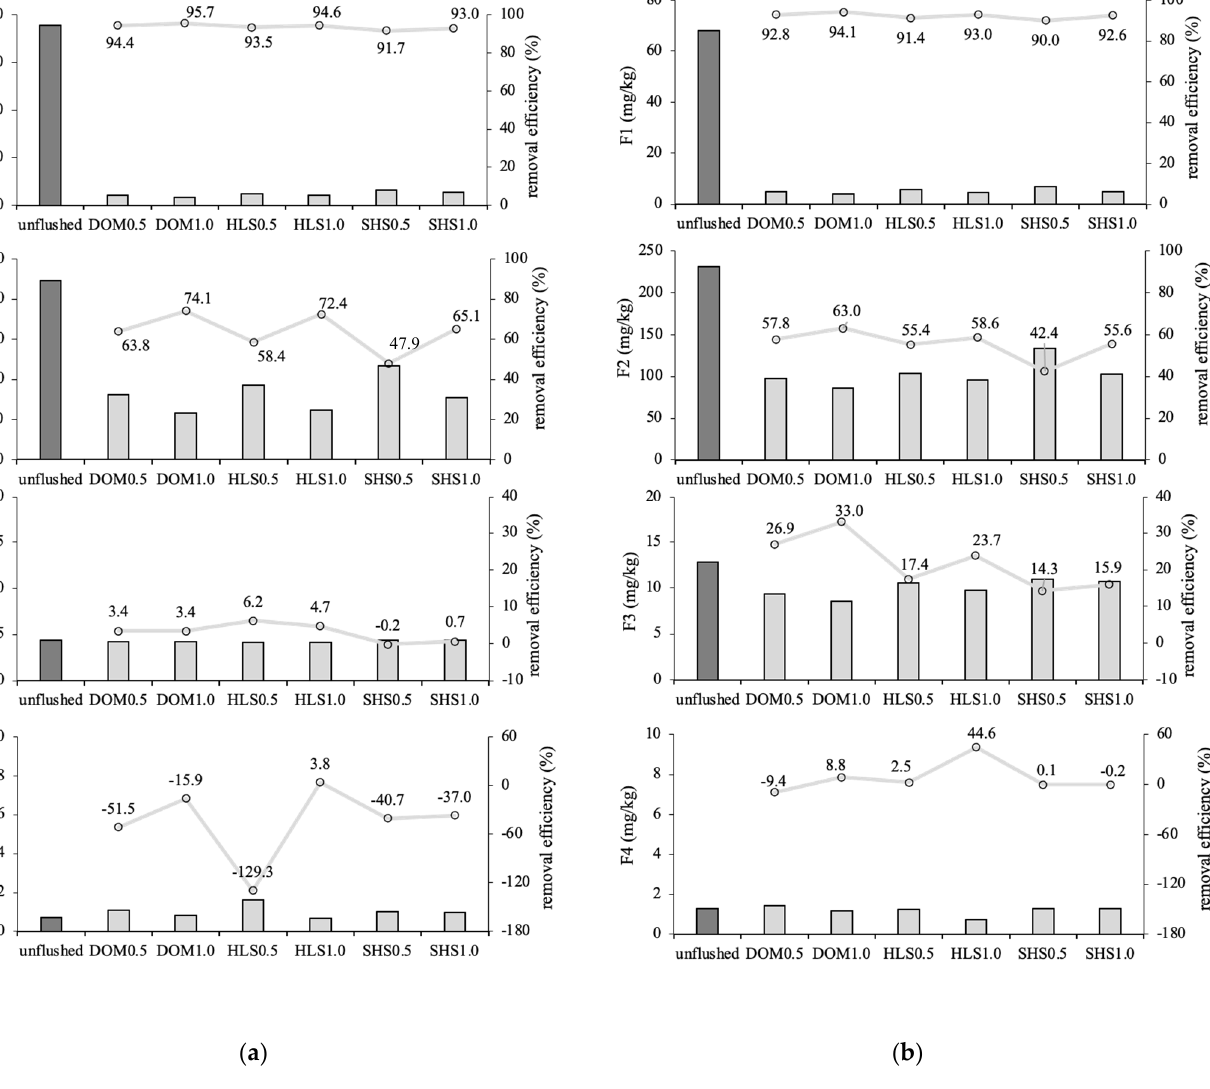
Figure 2. Distribution of chemical forms (F1, exchangeable and acid-soluble; F2, reducible; F3, oxidized and F4, residual) and the efficiency of their removal with DOM, HLS, and SHS in ( a ) S1, ( b ) S2.